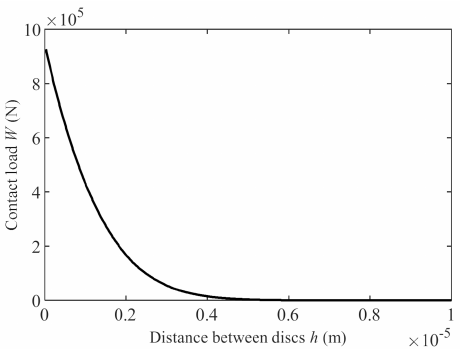
Figure 4. Relationship between contact load and distance between disks.